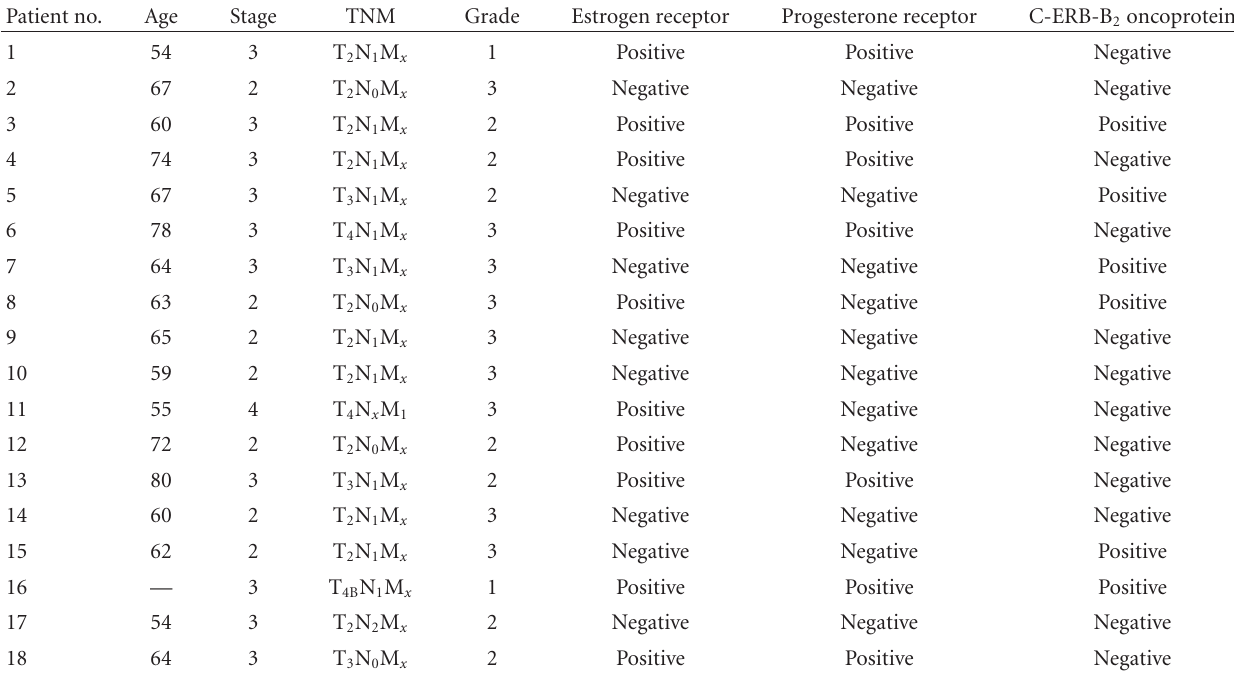
Table 1: Patient information.